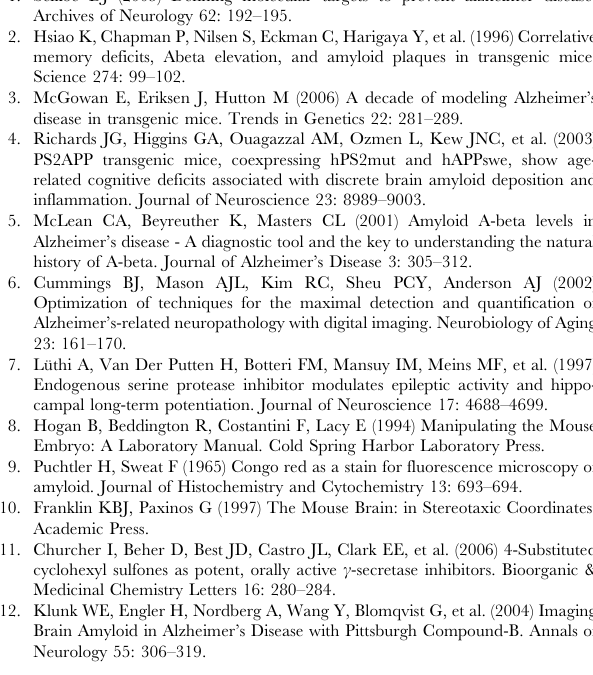
Figure S9 Statistical analysis of synaptic marker mRNA expression analysis. A, Synaptophysin (Syp), B, Disk large homolog 4 (Dlgh4), and C, Drebrin (Dbn1) mRNA expression in hemizygous and homozygous ART10 mice were analyzed in comparison to wild type animals. Material from comparable brain regions of mice ranging from 3 to 13 months of age was used for each of these studies. mRNA has been extracted from the brain material and expression of Synaptophysin, Disk large homolog 4, and Drebrin was measured applying real-time quantitative PCR.